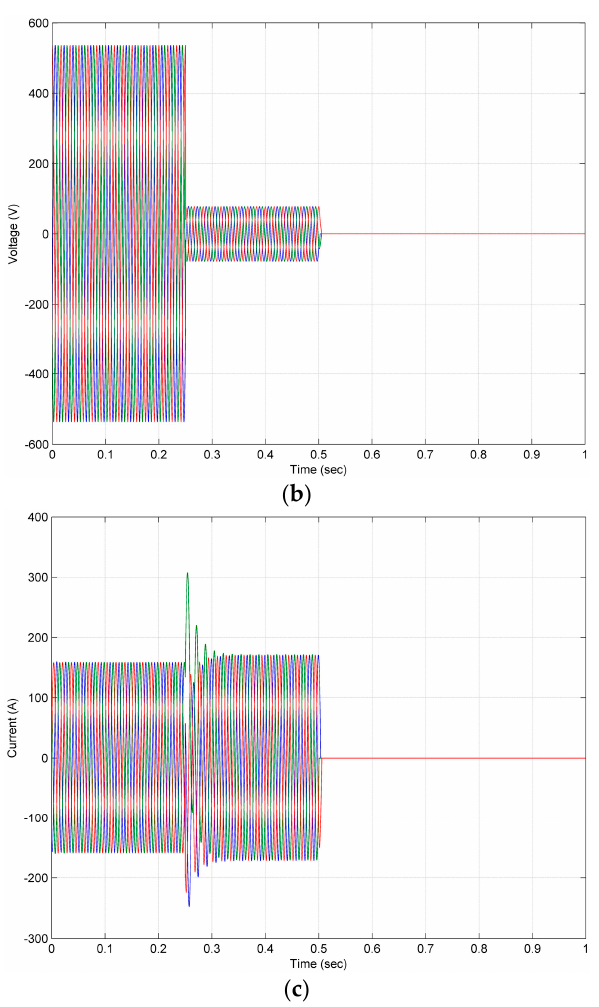
Figure 10. ( a ) CB10 CLOSE/TRIP state; ( b ) Feeder voltage waveforms of CB10 under grid-connected mode, fault occurrence at Bus 1 and failure trip of CB10; ( c ) Feeder current waveforms of CB10 under grid-connected mode, fault occurrence at Bus 1 and failure trip of CB10.